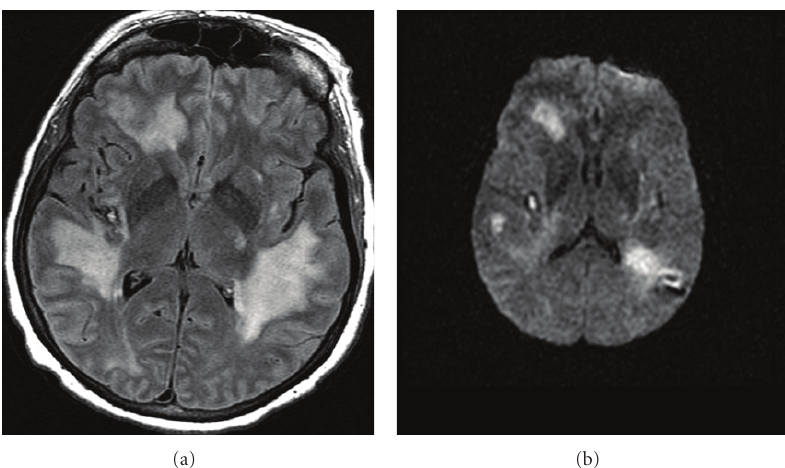
Figure 1: Multiple confluent white matter lesions demonstrated by 3mm axial fluid attenuated inversion recovery (FLAIR) brain magnetic resonance images (MRIs) demonstrating and di ff usion weighted imaging (DWI), respectively.